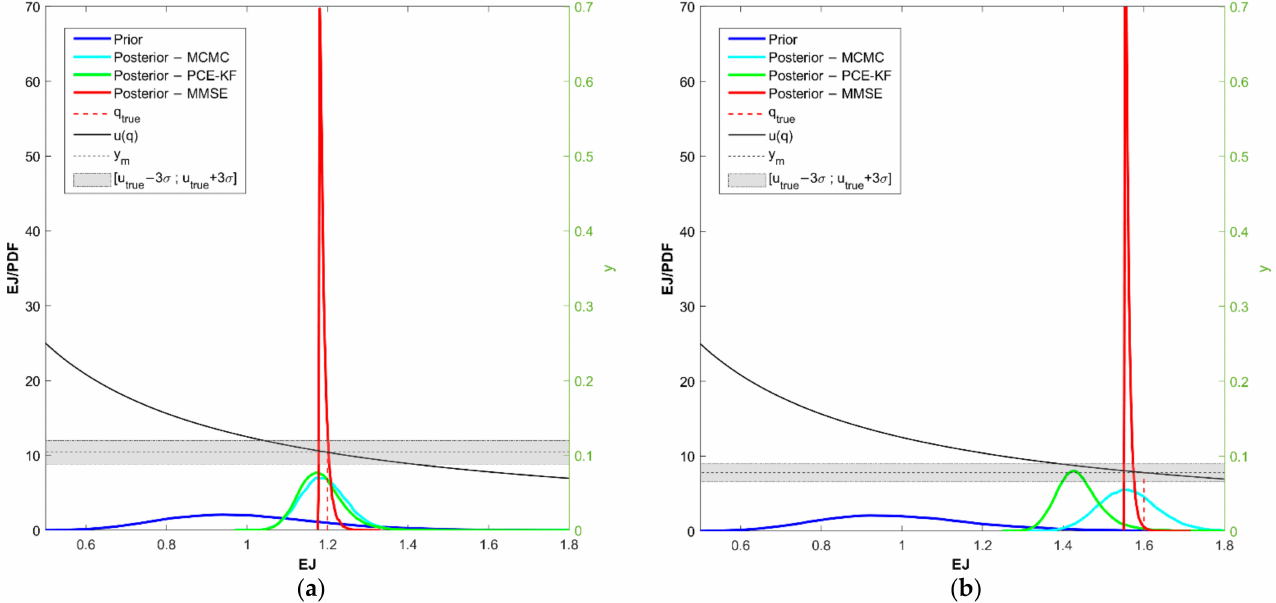
Figure 6. Comparison of updating procedures—cantilever beam: ( a ) EJ true = m + s = 1.2 and ( b ) EJ true = m + 3 s = 1.6. In each figure, the following are reported: the prior PDF (in blue); the posterior PDFs obtained via MCMC (in cyan), via PCE-KF (in green) and via NL-MMSE (red solid line); the true value of the parameter q true (red dashed line); the model response u ( q ) (black solid line); the measurement y m (black dashed line); the ± 3 σ ε region .of the measurement (grey